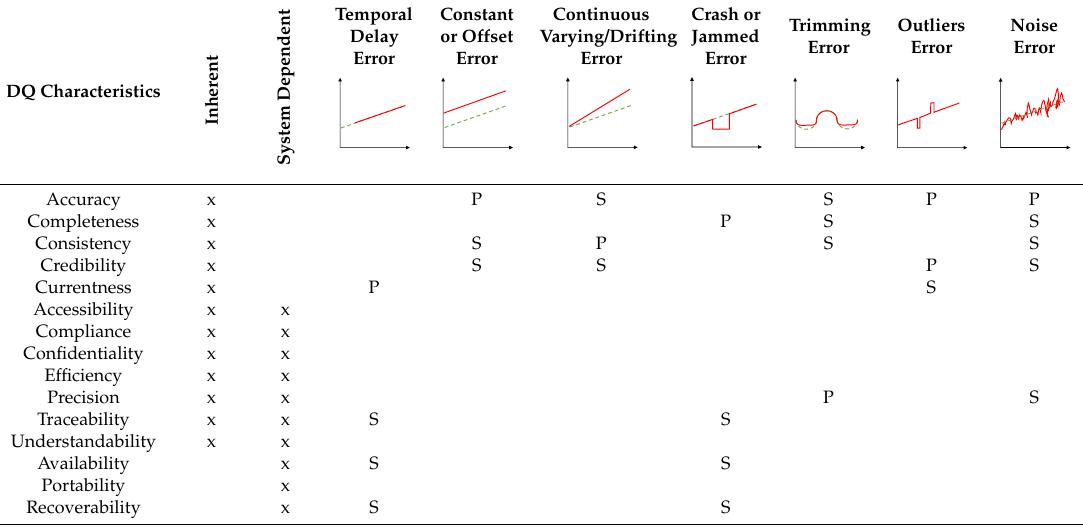
Table 4. DQ Characteristics in ISO/IEC 25012 that can be affected by sensor data errors.